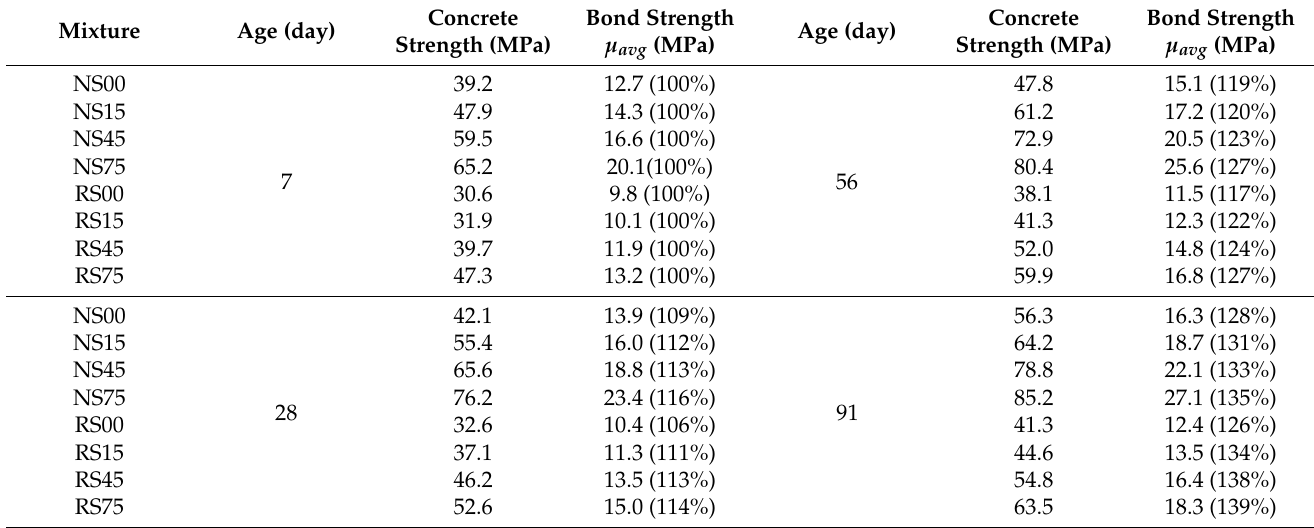
Table 5. Bond strength of concretes measured from pull-out